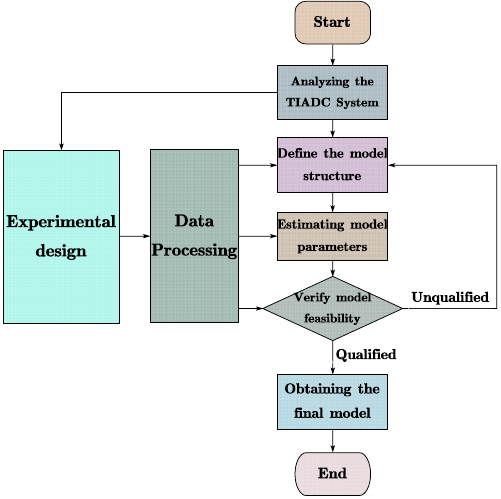
Figure 3. Process of establishing the TIADC system identification